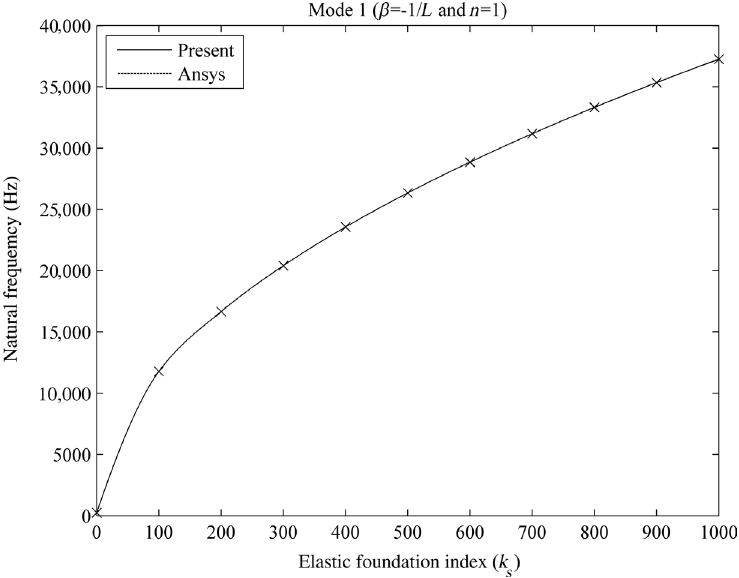
Figure 5 Variations of the natural frequencies with elastic foundation index ( k